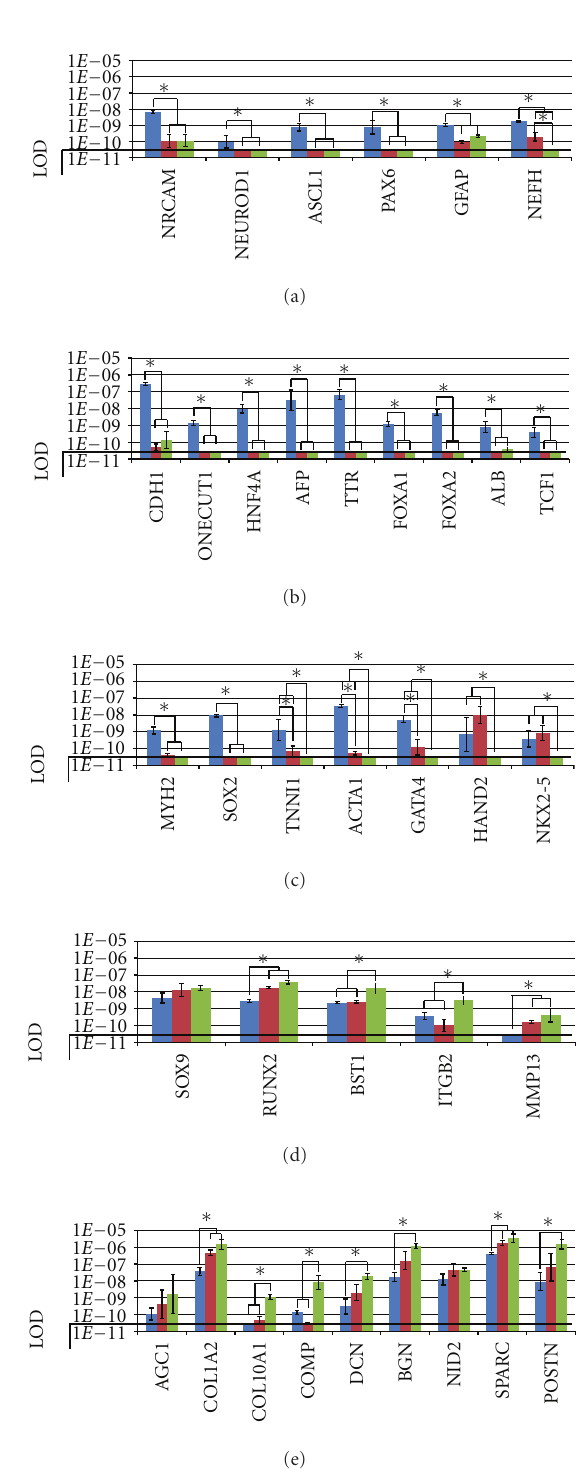
Figure 2: Di ff erentiation gene expression levels in hESC (blue), hES-MSC (Red), or hMSC (green) populations. The di ff erentiation genes are classified as follow: (a) neuroectodermic genes; (b) endodermic genes; (c) mesodermic genes; (d) and (e) mesenchymal genes including transcription factors, cell adhesion molecules, and protease genes (d) and Extra-cellular matrix genes (e). y-axis values correspond to 2 − NCt as described in Material and Methods. The black line represents the limit of detection (LOD: > 35Ct). Asterisks ( ∗ ) indicate significant expression variation with P < 0 .